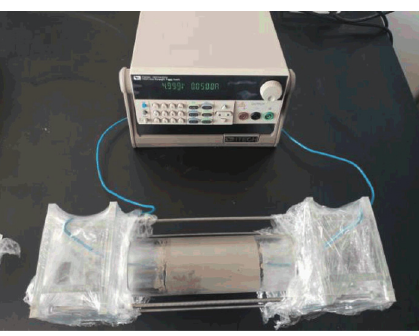
Figure 3: Electrochemical treatment on HWBM samples.